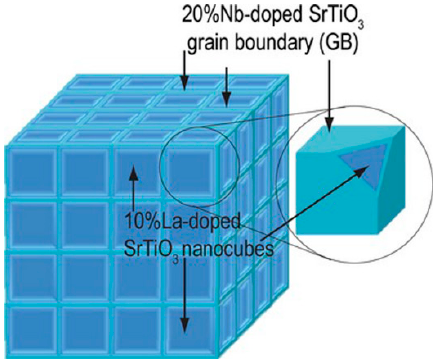
Figure 6. “Rubik’s cube” structure of the SrTiO 3 ceramics (2DEG grain boundaries are shown in light blue, grain interiors—in deep blue). Reproduced with permission from Reference [11].